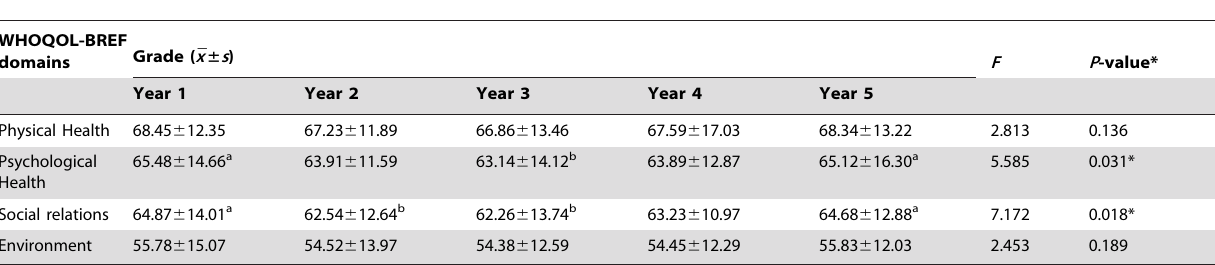
Table 3. Scores of medical students in different years.